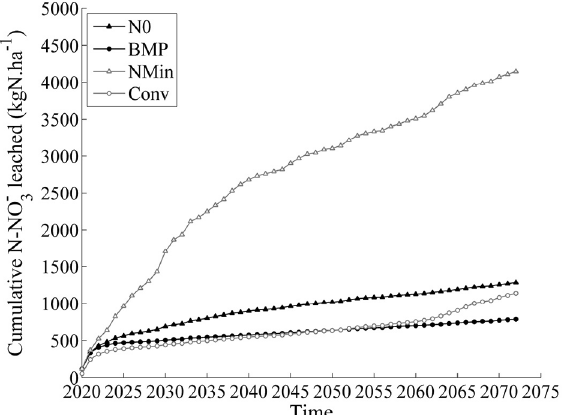
Fig 6. Simulated cumulative nitrate leaching. Simulated median cumulative nitrate leached for the NMIN (grey empty triangle line), CONV (grey empty circle line), N0 (black full triangle line) and BMP (black full circle line) treatments in the long term rotation (2020 – 2073) under